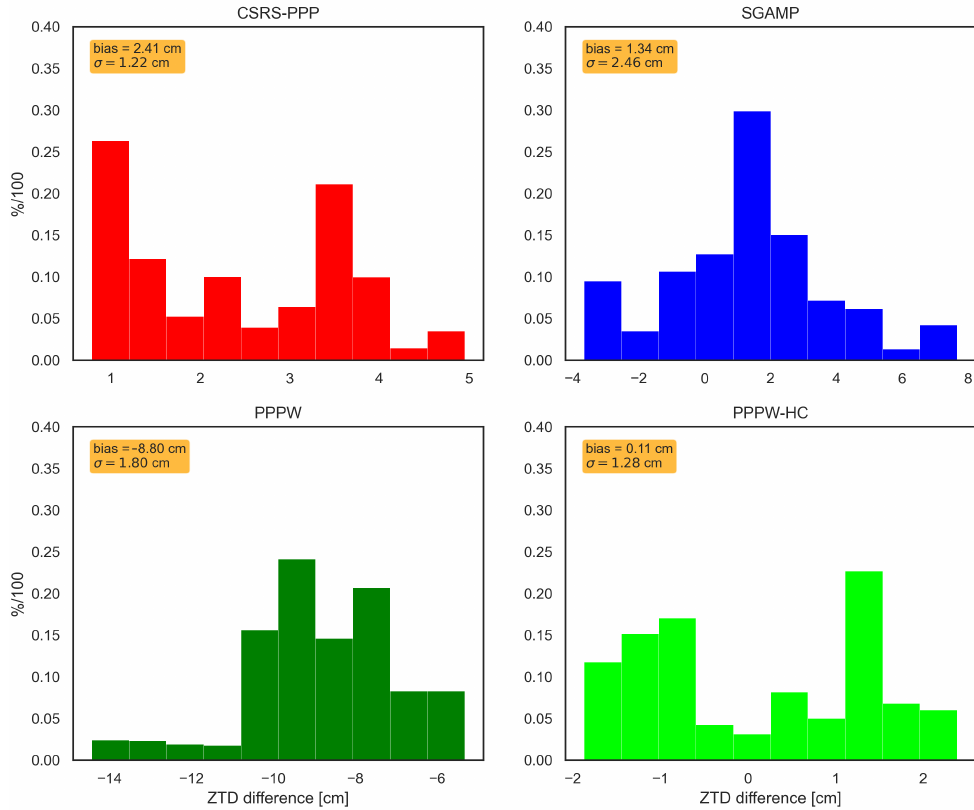
Figure 6. Histograms of the ZTD differences between the estimated GNSS-ZTD (CSRS-PPP (red), SGAMP (blue), PPP-Wizard (green), and PPPW-HC (lime)) and ERA-ZTD for CS1. Additionally, the bias and standard deviations are indicated for each GNSS-ZTD solution.